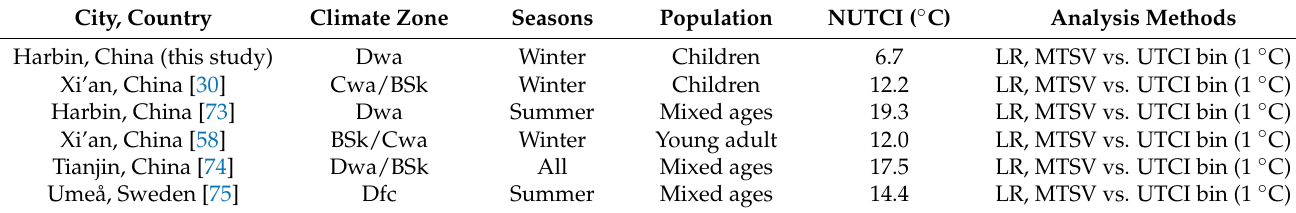
Table 10. Neutral UTCI in different OTC studies.